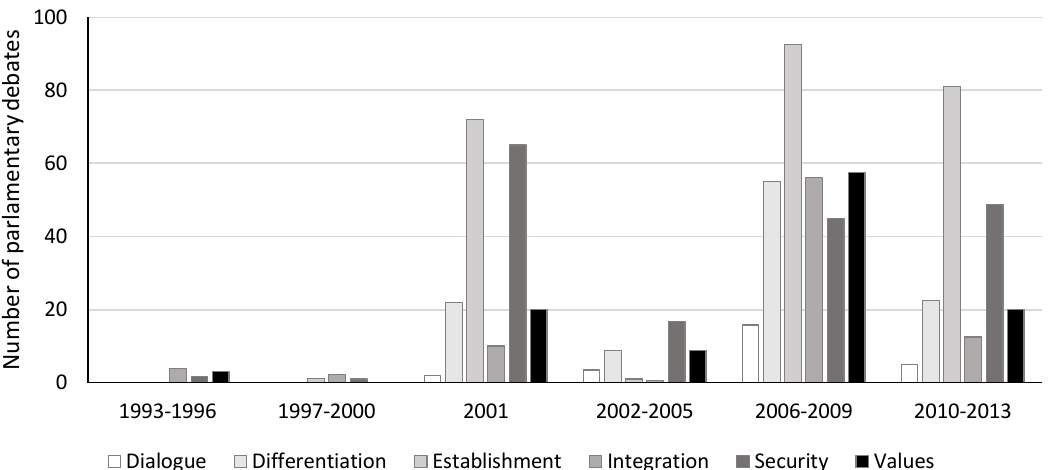
Figure 5. Issue clusters in references to Islam/Muslim in parliamentary integration debates in Austria, Germany and Switzerland, yearly averages. Source: (Mattes 2018, forthcoming), n = 811 parliamentary protocols between 1993 and 2013.